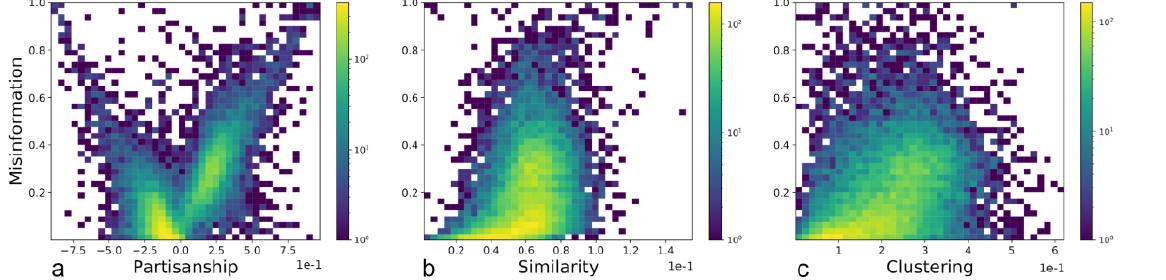
Figure 2. Relationship between misinformation and other variables. Color indicates the number of users. (a) Partisanship: the Pearson correlation is r = 0.64 for left-leaning users and r = 0.69 for right-leaning users. (b) Similarity: r = 0.33. (c) Clustering: r = 0.30. All correlations are significant (p <